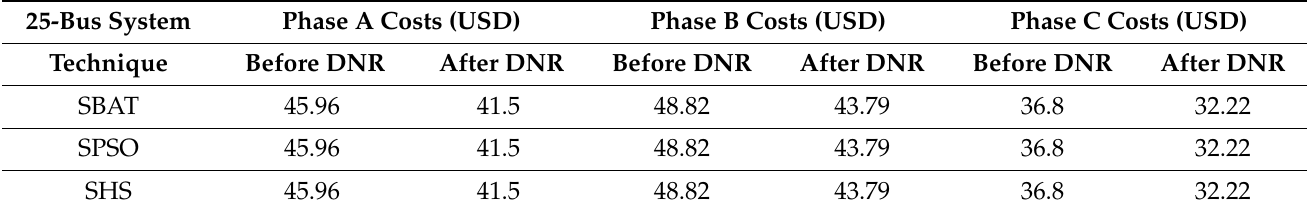
Table 15. Total costs per phase in 24 h (25-bus system/variable